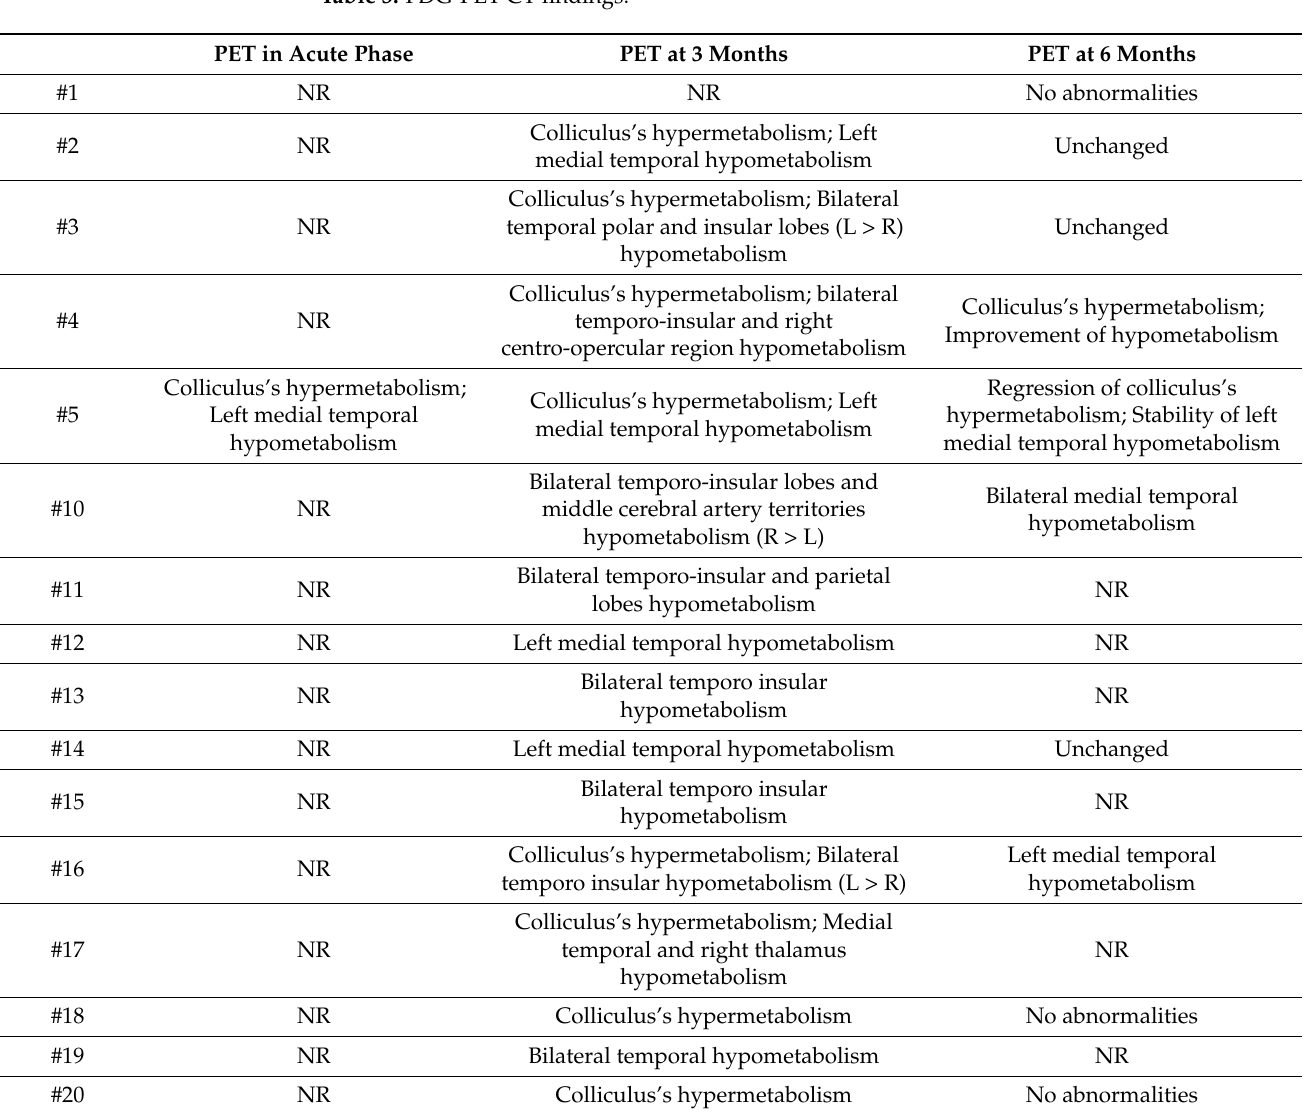
Table 3. FDG-PET CT